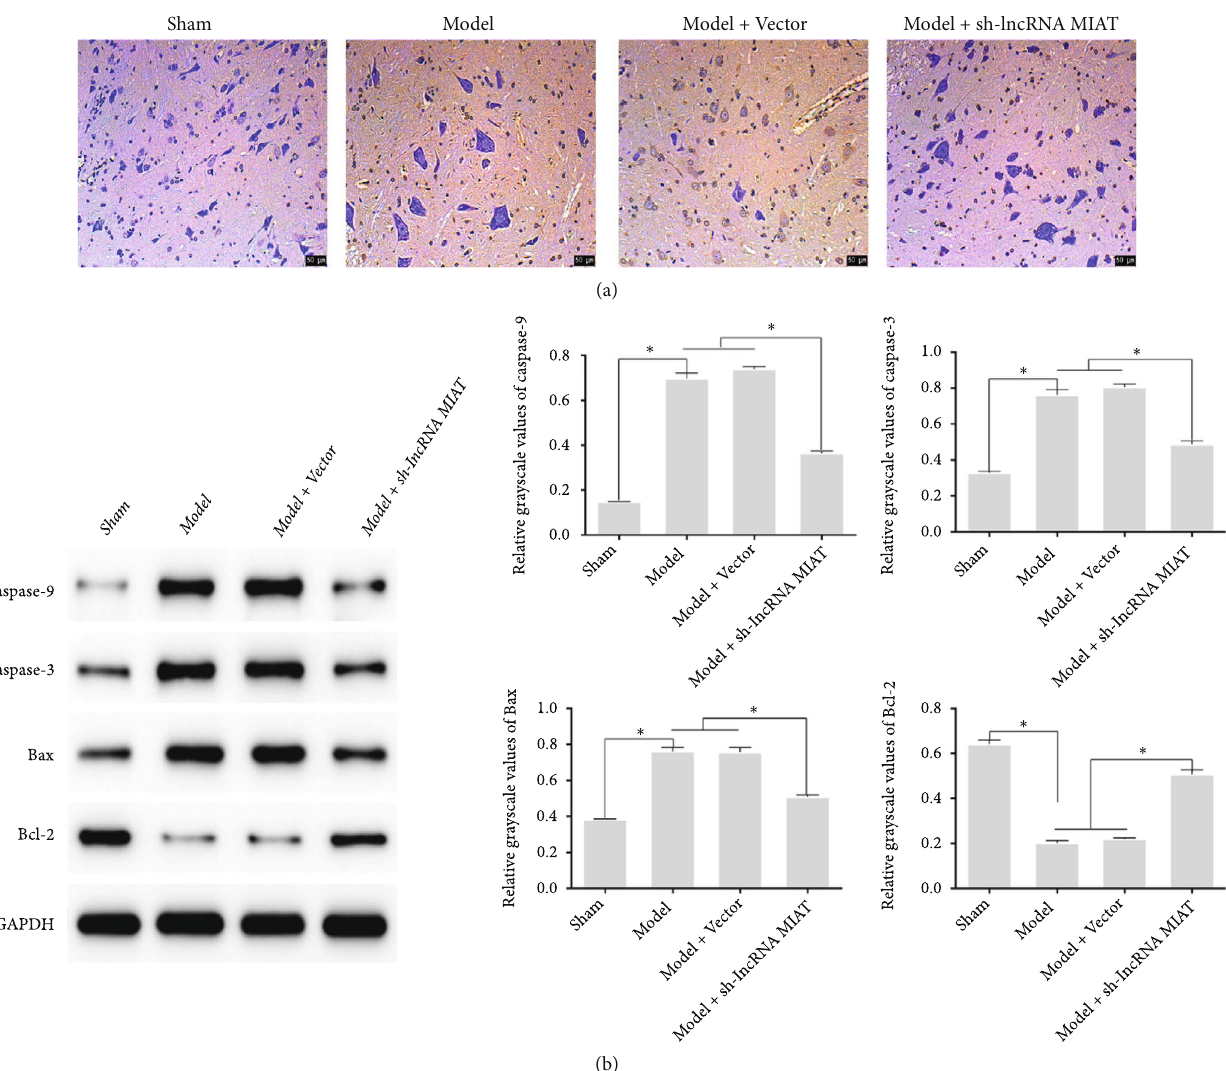
Figure 4: E ff ect of sh-lncRNA MIAT on apoptosis in SCIRI rats. (a) Apoptosis detection via TUNEL staining. (b) Detection of changes in apoptosis-associated proteins based on western